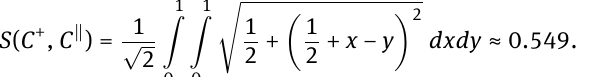
Then we get by a similar